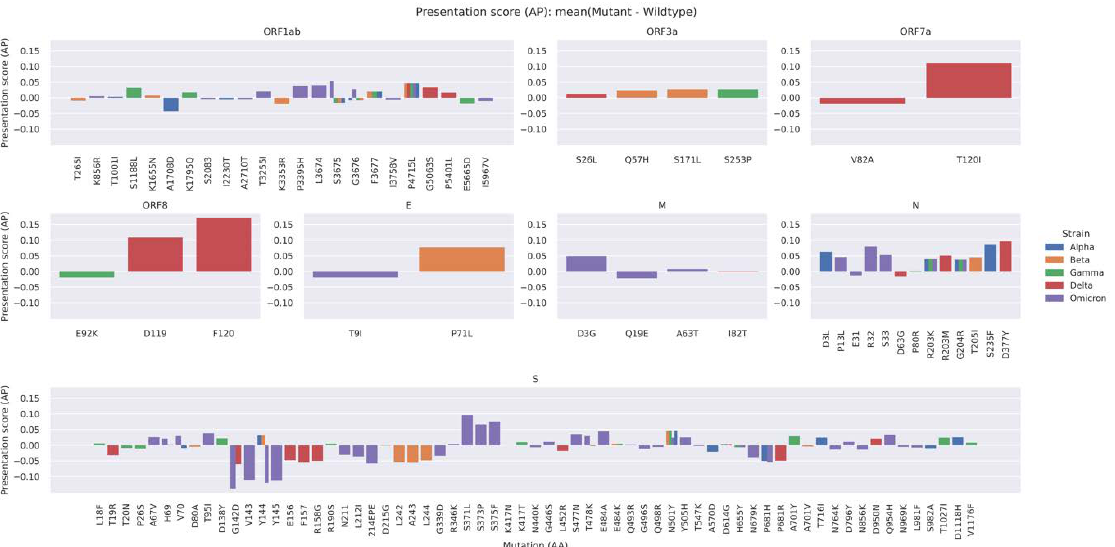
Figure 4. Average difference in AP score (mutant–wildtype) for each mutation in the VOC, denoted by the different colors. Each plot corresponds to a protein of the virus in which mutations occurred.